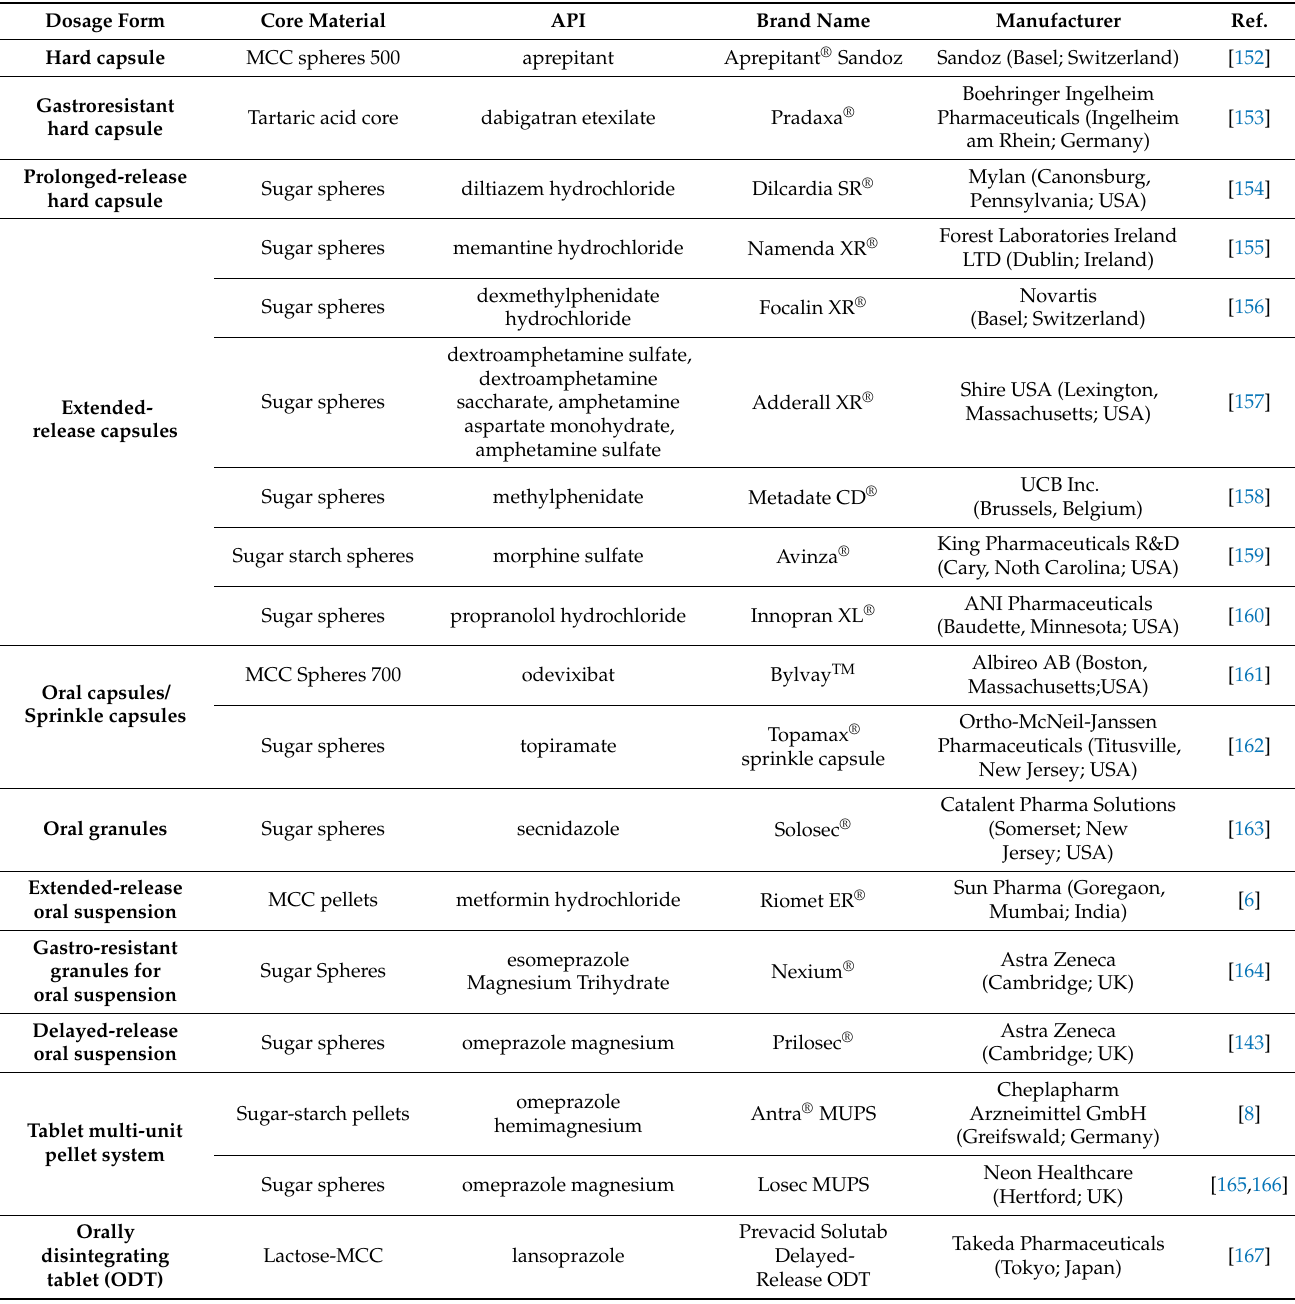
Table 5. Examples of starter pellet formulations used in different dosage forms